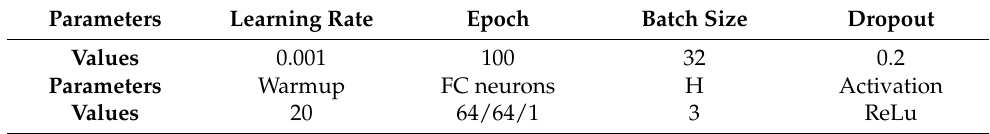
Table 3. Hyperparameter